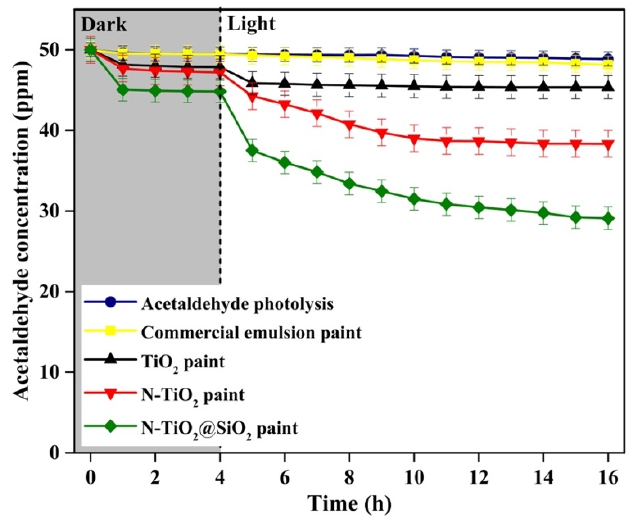
Figure 9. Adsorption (in the dark) and photocatalytic performance of gaseous acetaldehyde decom- position by different photocatalytic paints under LED visible light at room temperature within 16 h.